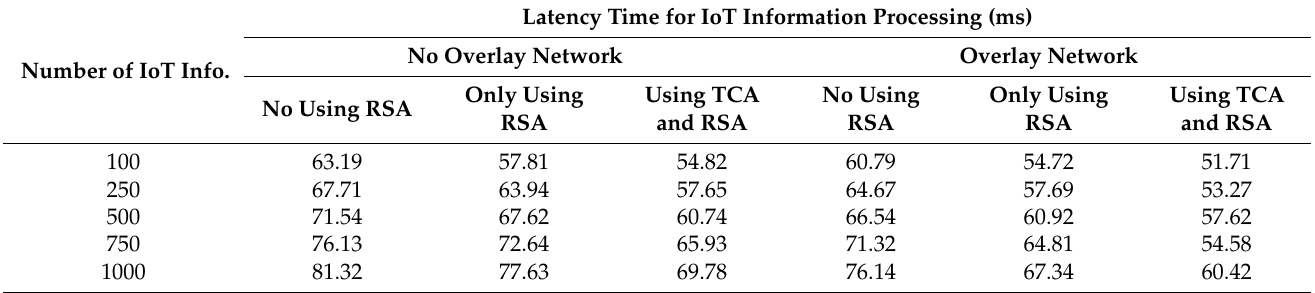
Table 7. Blockchain-based integrity verification overhead